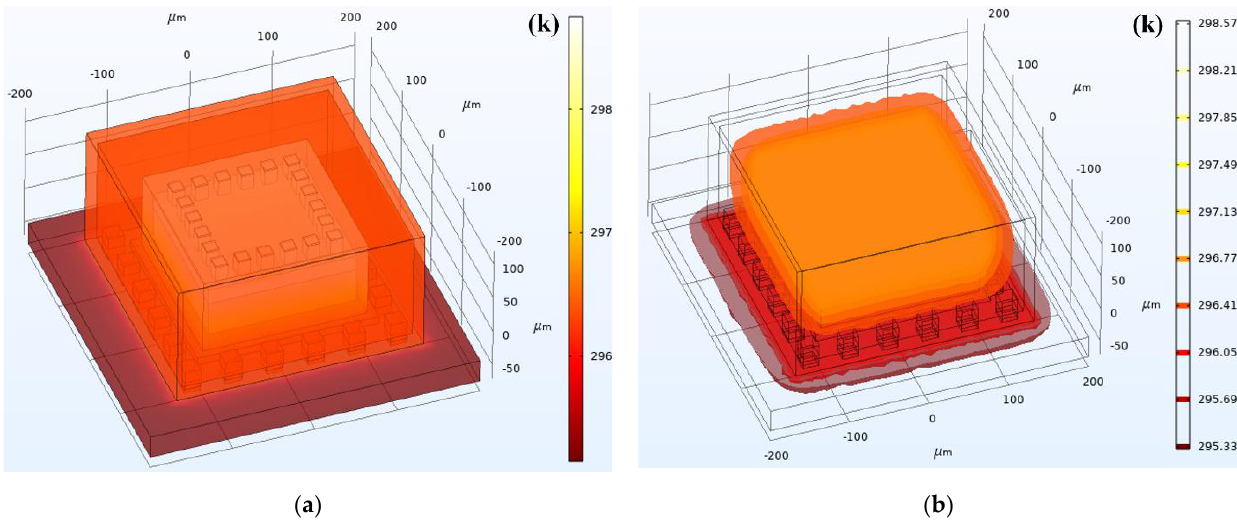
Figure 9. ( a ) Transient temperature distribution and ( b ) isothermals within TFGs during their working processes.